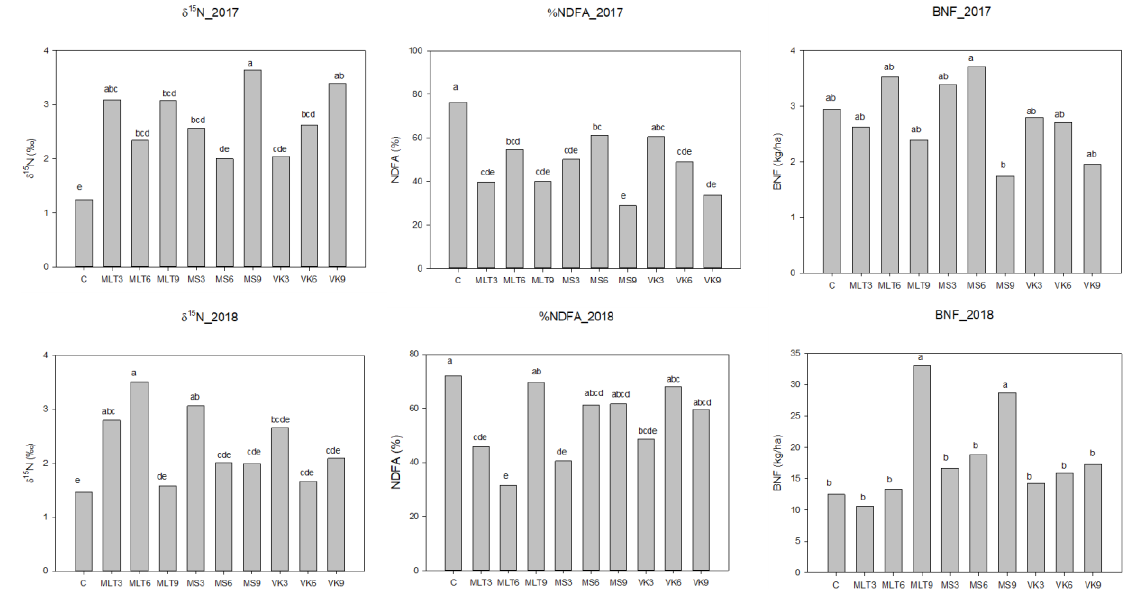
Figure 6. δ 15 N, percentage nitrogen derived from air and biologically fixed nitrogen at Ofcolaco in the 2017 and 2018 seasons. MLT is Moringa Oleifera leaves and twigs applied at rates of 3 tons/ha (MLT3), 6 tons/ha (MLT6) and 9 tons/ha (MLT9); MS is M. Oleifera stems applied at rates of 3 tons/ha (MS3), 6 tons/ha (MS6) and 9 tons/ha (MS9); VK is Vachelia Karoo leaves and twigs applied at rates of 3 tons/ha (VK3), 6 tons/ha (VK6) and 9 tons/ha (VK9). Different letters show significant differences. Table 7. Nodules/plant, nodule weight and root weight at Ofcolaco in 2017 and 2018. The number of nodules per plant in the 2017 season was high in the VK9 treatment, with 6.09, compared to MLT6 and MLT9. In 2018, the highest number of nodules per plant were observed in MS9 and MLT9, which both had just over 13 (Table 7). The average number of nodules per plant was more than double in 2018 (9.11) compared to 2017 (4.21). Nodule weight did not differ between the treatments in 2017 but showed significant differences in 2018. The average nodule weight in 2017 was 0.09 g, while in 2018, it was 1.99 g. The root weight differed significantly among the treatments in 2017, while in 2018, differences were only observed between the control and the rest of the treatments.